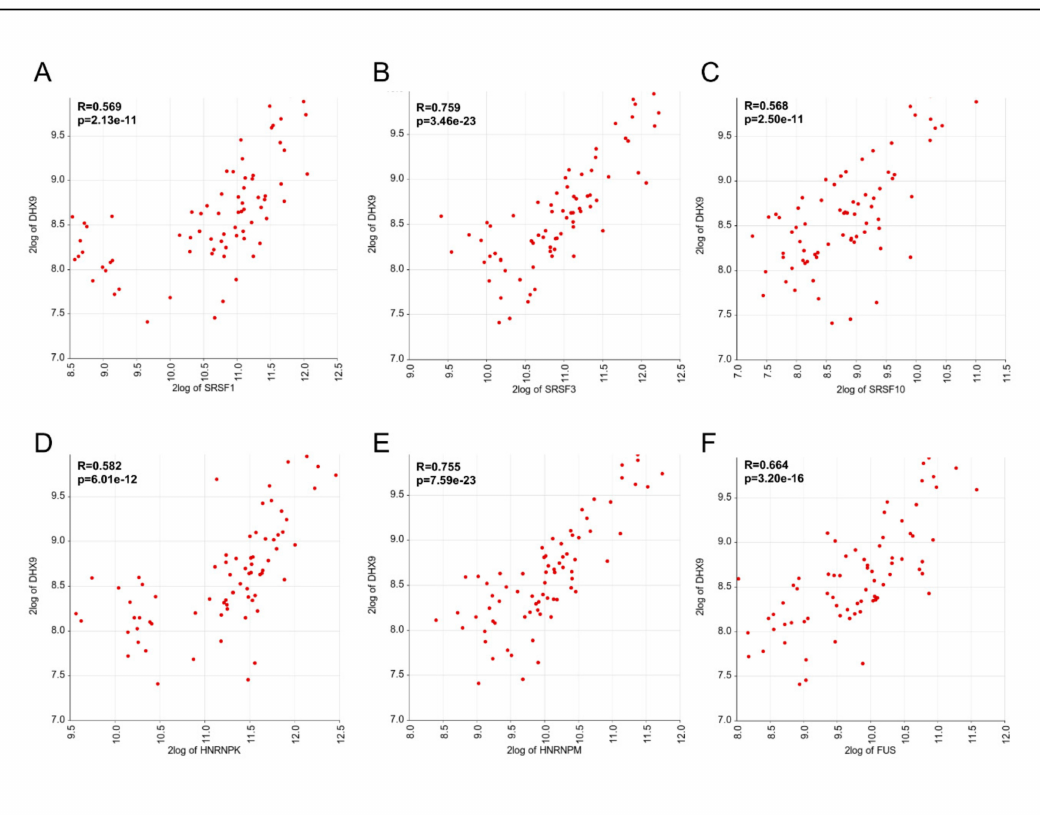
Figure 2. SRSF3 and hnRNPM expression in ES patients exhibit a significant correlation with DHX9 expression. Pearson correlation analysis on Ewing sarcoma patients, performed between the expression of DHX9 and SRSF1 ( A ), SRSF3 ( B ), SRSF10 ( C ), hnRNPK ( D ), hnRNPM ( E ), or FUS ( F ). Values are expressed as base 2-logarithm. In each panel, the correlation value (R) and the relative p -value are